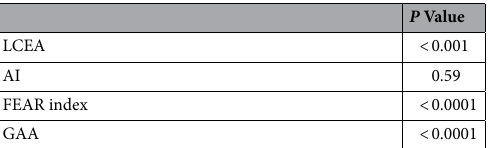
Table 5. Logistic regression analysis of radiographic parameters for instability a . a AI acetabular index, GAA